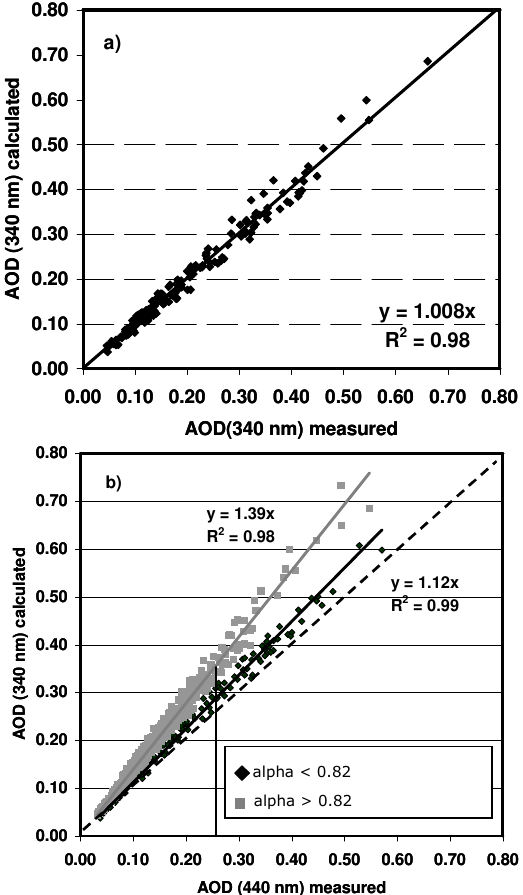
Fig. 1. (a) Calculated AOD at 340nm (based on extrapolated data at 440nm using the alpha climatological AERONET values) as func- tion of measured AOD at 340nm during a year of measurements and its fit; (b) calculated AOD values at 340nm as function of the measured AOD at 440nm during the analysed period (2004–2008) for alpha less and greater than 0.82. Also both fits are shown.